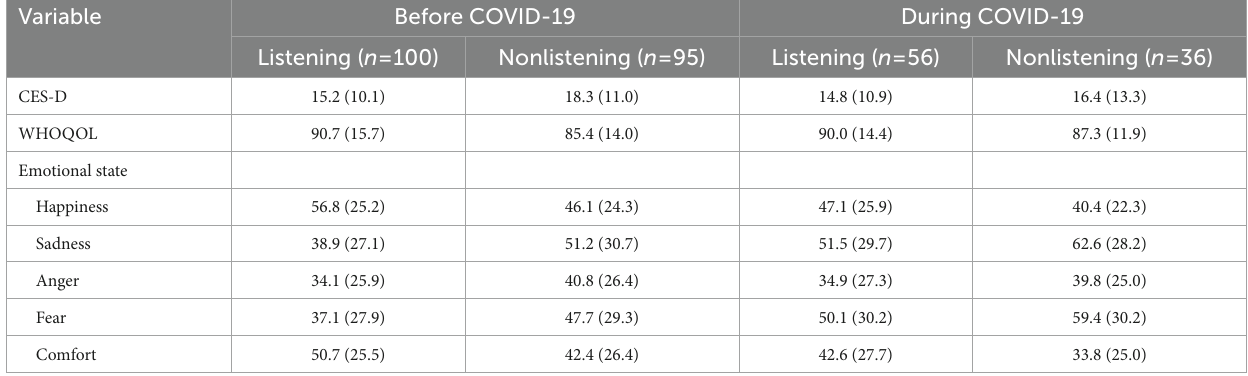
TABLE 3 Perceived levels of depression and quality of life for the two